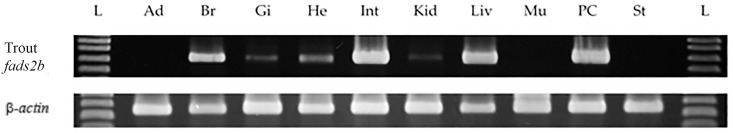
The expression pattern of fads2b mRNA in different tissues of rainbow trout as determined by conventional RT-PCR for 36 cycles.A partial β-actin mRNA was used as an internal standard. A similar fads2b mRNA distribution profile was obtained in three animals. Ladder L, Adipose tissue Ad, Brain Br, Gill Gi, Heart He, Intestine Int, Kidney Kid, Liver Liv, Muscle Mu, Pyloric caeca PC, Stomach St.